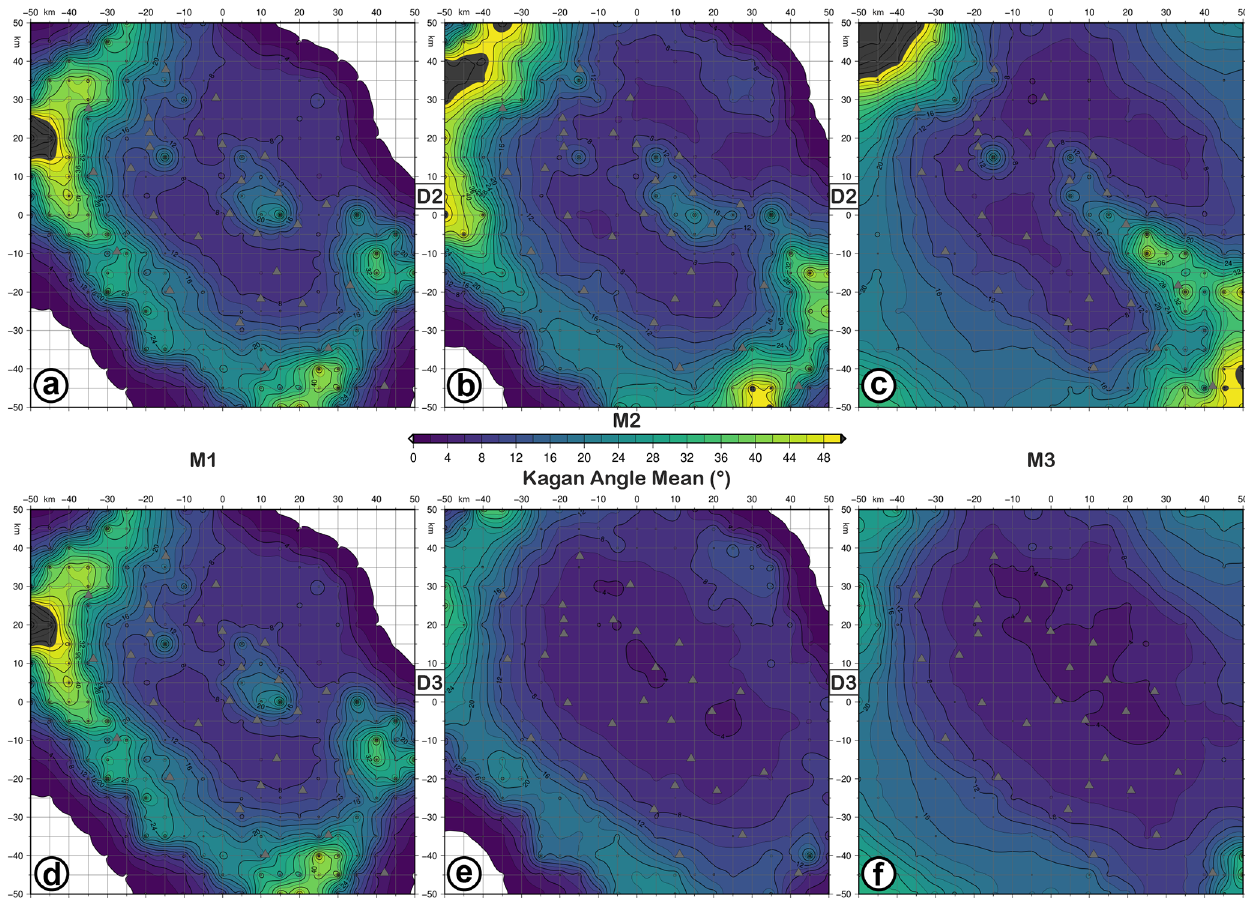
Figure 7. KAA (Kagan angle average) maps for retrieved focal mechanisms with D2 (a–c) and D3 (d–f) datasets as input data and simulating earthquakes with M1 (a, d) , M2 (b, e) , and M3 (c, f) magnitudes and the FM1 theoretical fault plane solution at 10km depth. The level of Gaussian noise is set to